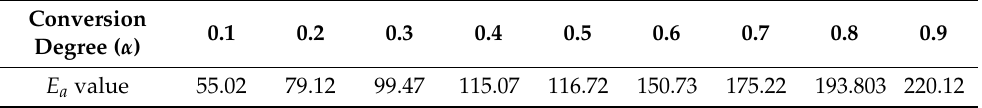
Table 4. Apparent activation energy values computed at overall reduction reaction.